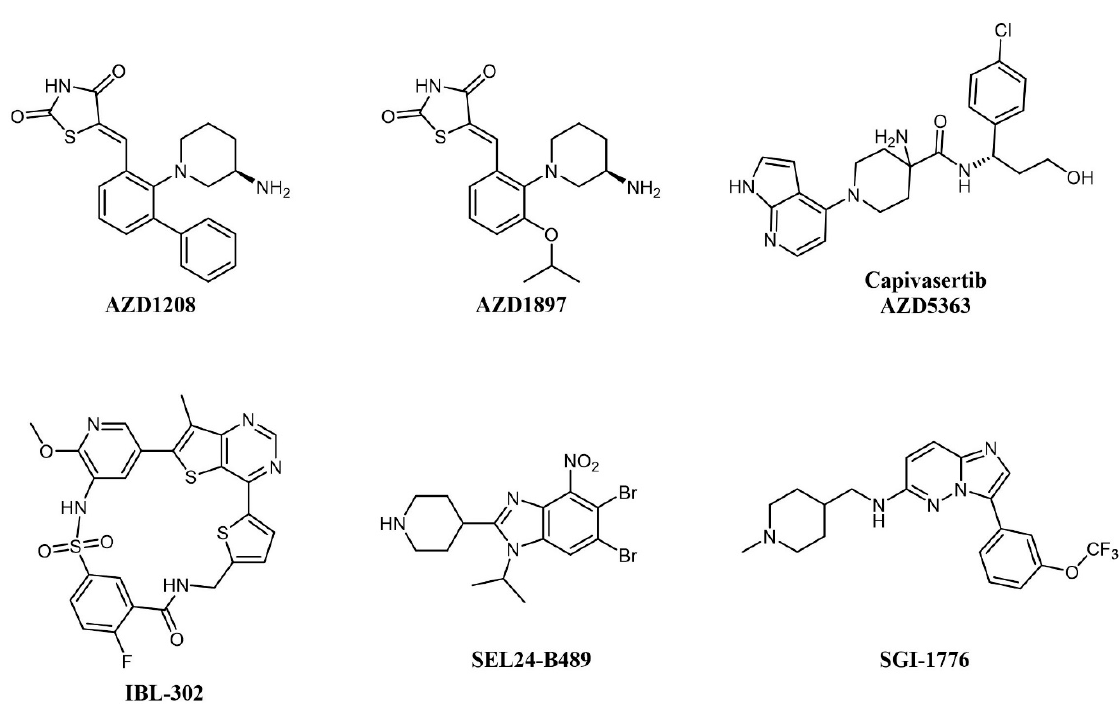
Cancers 2021 , 13 , x Figure 4. Chemical structure of multi-targeting PIM inhibitors used for AML treatment. The structure of the phosphatidylinositol 3-kinase/protein kinase B (AKT) inhibitor Capivasertib (used in combination with AZD1897) is also reported.